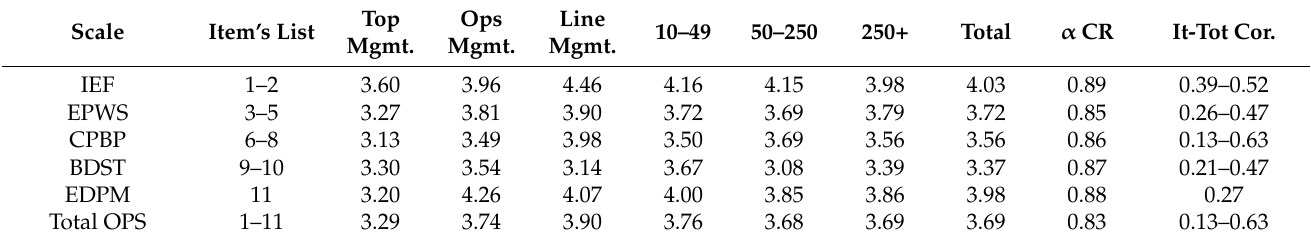
Table 5. Scales of operational risk perception.